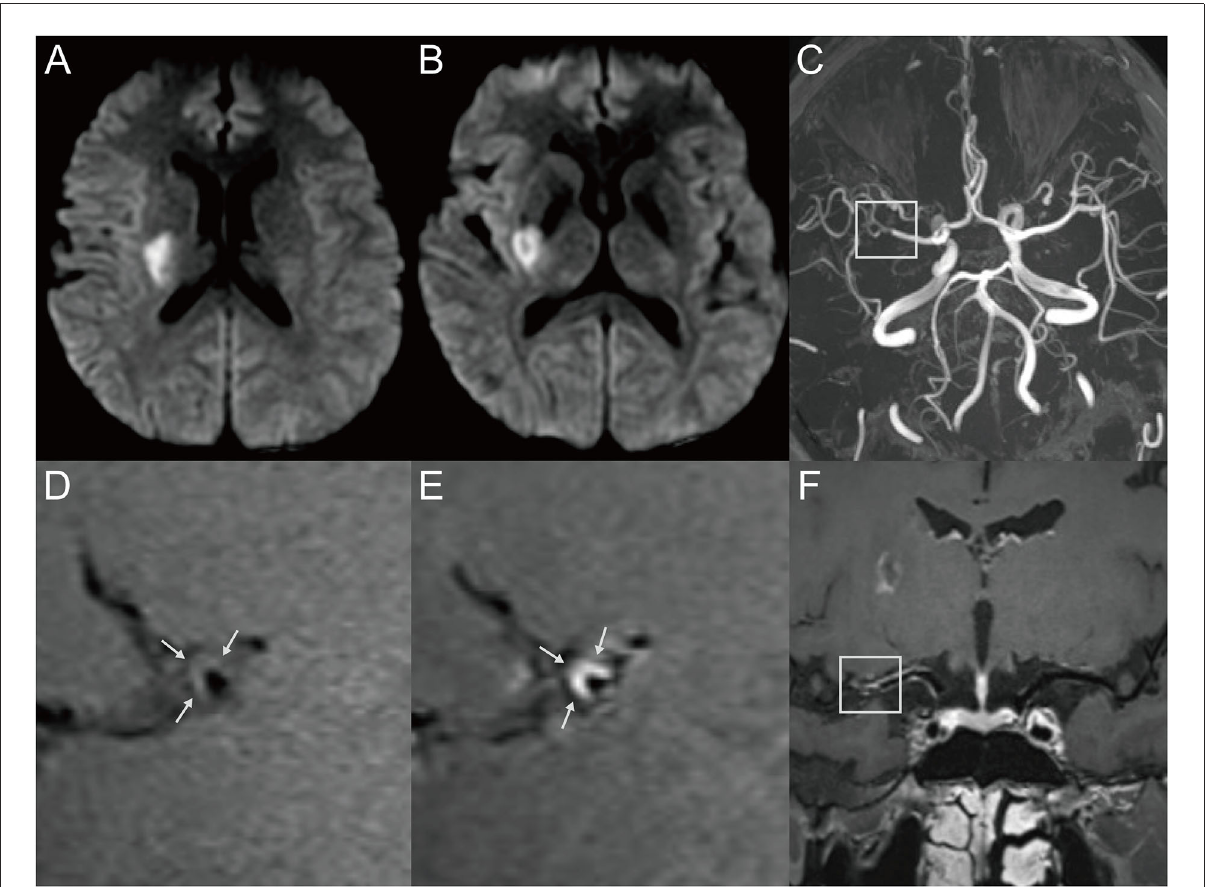
FIGURE1 Representative MR images of a 34-year-old male patient with a single acute infarct lesion. The patient presented with left-side weakness for 2 days. The patient’s risk factors included hypertension and hyperlipidemia. (A,B) The DWI images showed an infarct in the right basal ganglion region. (C) The 3D-TOF-MRA showed moderate stenosis of the right middle cerebral artery (MCA) (box). (D) The T1-weighted HRMRI demonstrated an eccentric atherosclerotic plaque with iso-signal intensity at the corresponding location (arrow), indicating probable parent artery atherosclerosis occluding a penetrating artery. (E) Postcontrast T1-weighted HRMRI showed strong enhancement of the plaque (arrow). (F) The postcontrast T1-weighted image by curved planar reformation showed the location of the plaque, which involved the superior wall where the perforator originated